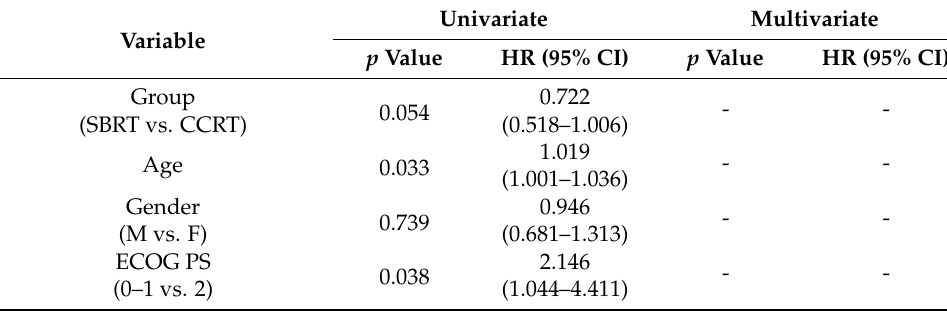
Figure 1. Recurrence and survival outcomes in the unmatched cohort. ( A ) overall survival (OS); ( B ) progression-free survival (PFS); ( C ) freedom from local progression (FFLP). Table 2. Variables associated with overall survival.